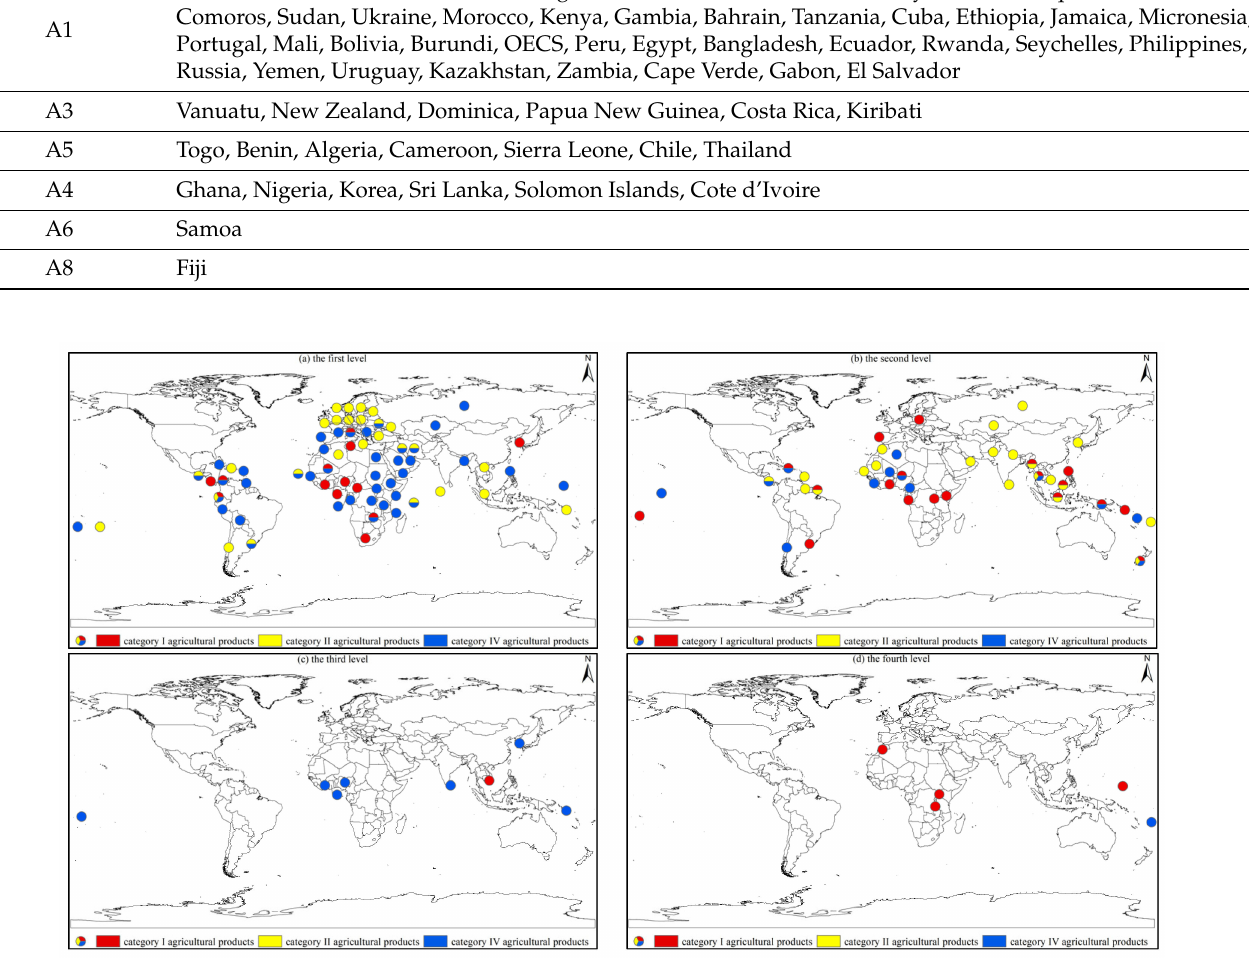
Figure 7. Results of the level division of the key trading